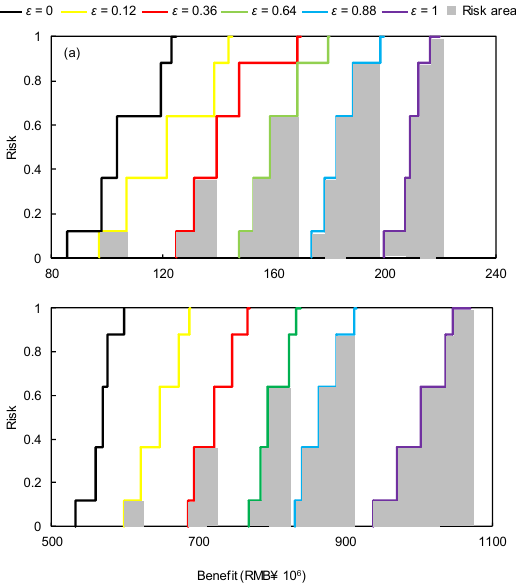
Figure 5. Cumulative risk curve (( a ) Lower bound and ( b ) Upper bound).